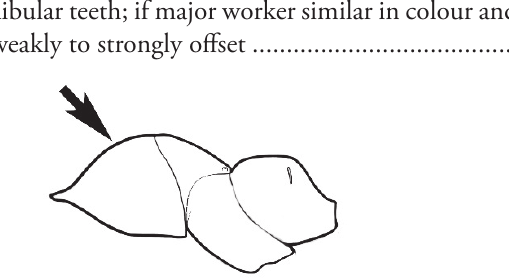
than five mandibular teeth; if major worker similar in colour and profile, then